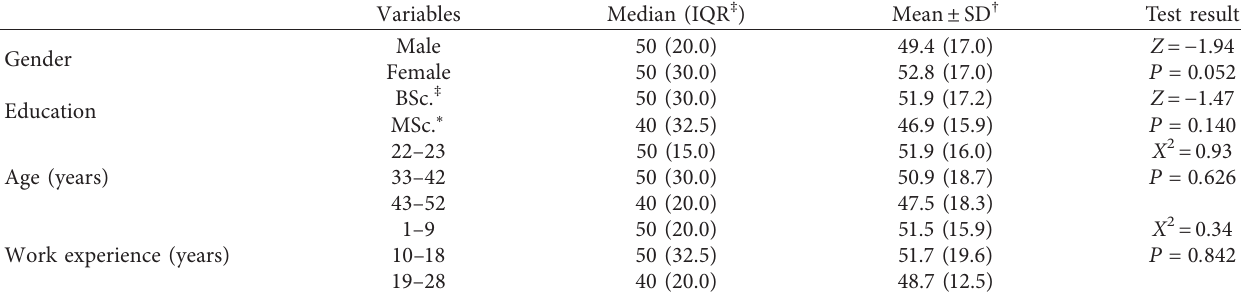
Table 5: Relationship between nurses’ practice of toothbrush maintenance and use with demographic